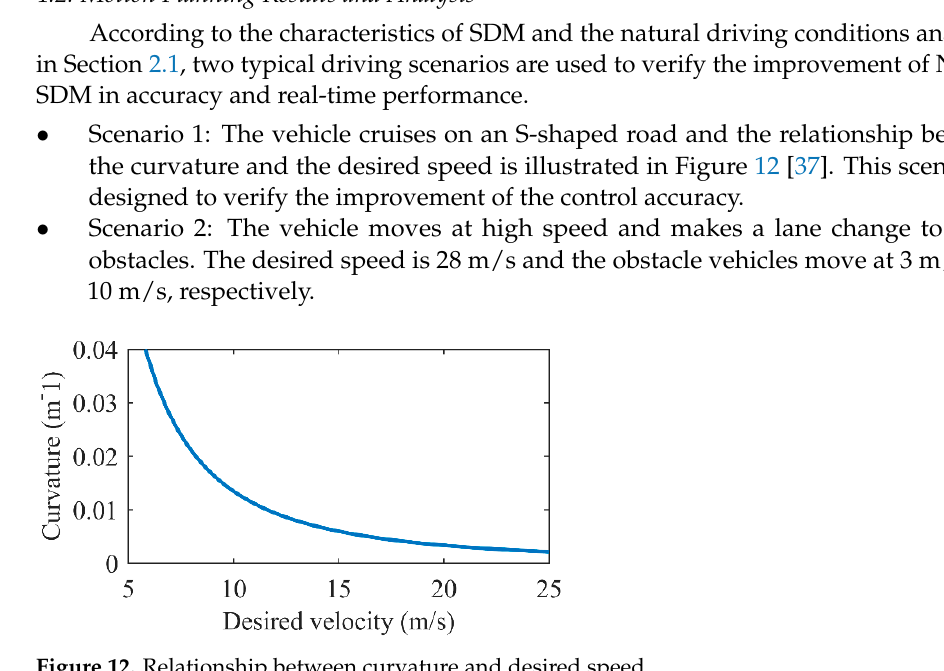
( b ) Figure 13. The statistical results: ( a ) lateral error position error; ( b ) longitudinal speed error. There is no obstacle in scenario 1 and so the consumption of computation resources is much less. Besides the tracking control performance, the consumption of computation resources is further analyzed in Scenario 2, where the motion planner should find the op- timal solution to avoid collisions with two obstacle vehicles, meanwhile tracking the de- sired speed as much as possible. The comparative simulations are shown in Figures 14 and 15.